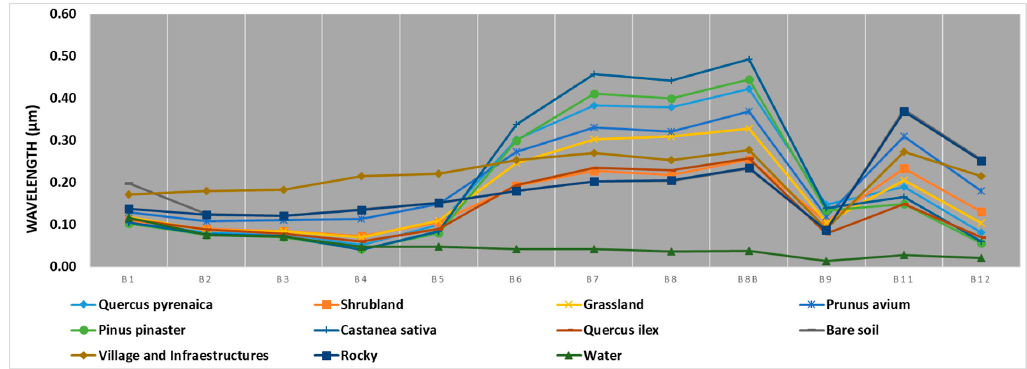
Figure 4. Spectral signature of the different types of vegetation and land uses in relation to wavelength ( μ m) by Sentinel 2 satellite bands.